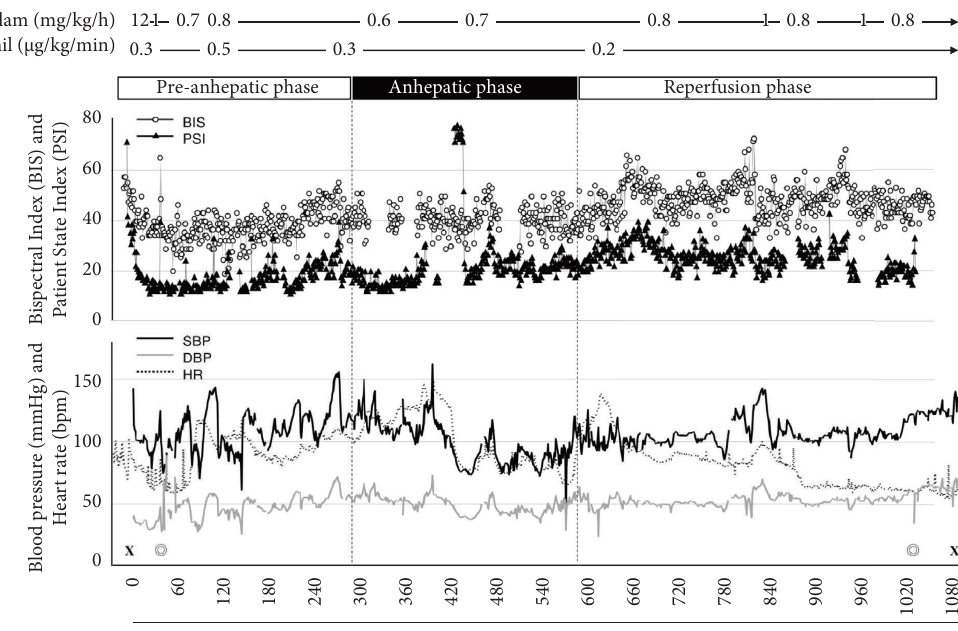
Figure 1: Anesthesia record. SBP: systolic blood pressure; DBP: diastolic blood pressure; HR: heart rate; X, start and end of anesthesia; and ◎ , start and end of